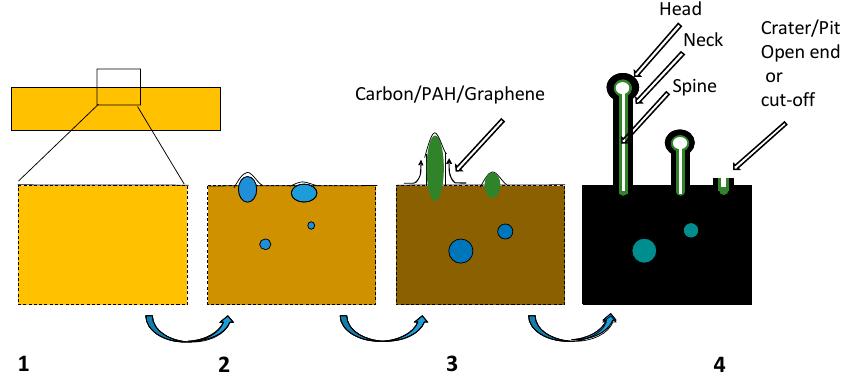
Figure 12. Proposed scheme on the formation of fingers and craters during combustion of spaghetti. Numbers 1 to 4 refer approximately to the corresponding regions marked in Figure 10.